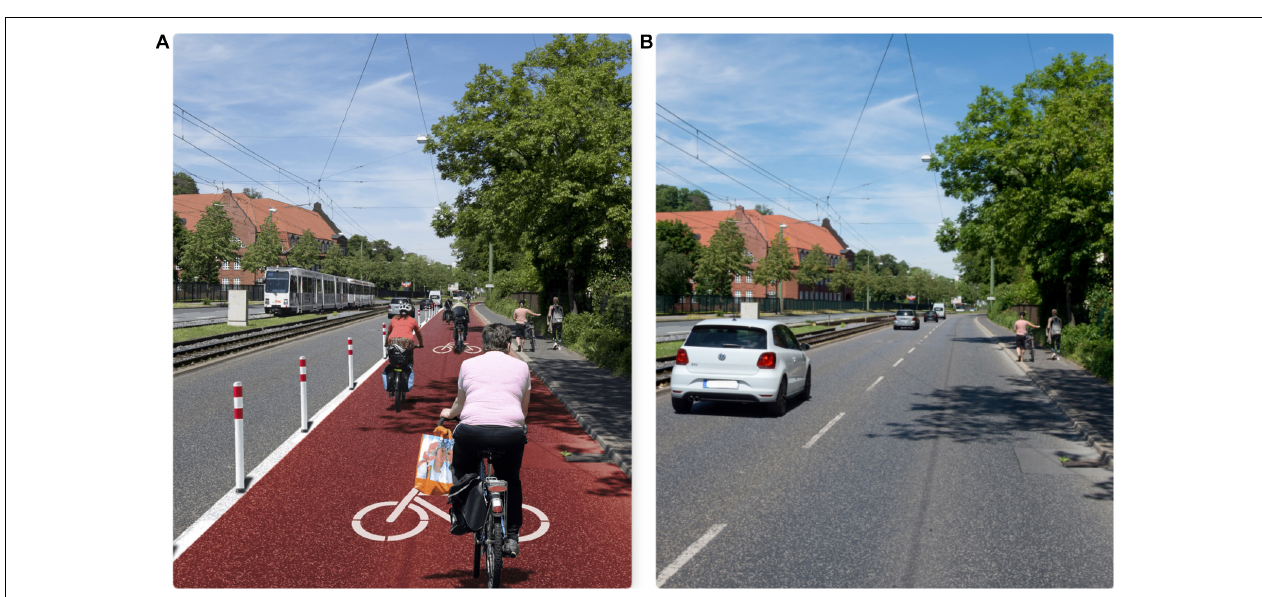
FIGURE 2 | Photomontages used for the experimental online study 2. On the left, the descriptive norm “sustainability-oriented mobility behavior” (A) ; on the right, the descriptive norm “car-oriented mobility behavior” (B) . (Photos: Michael